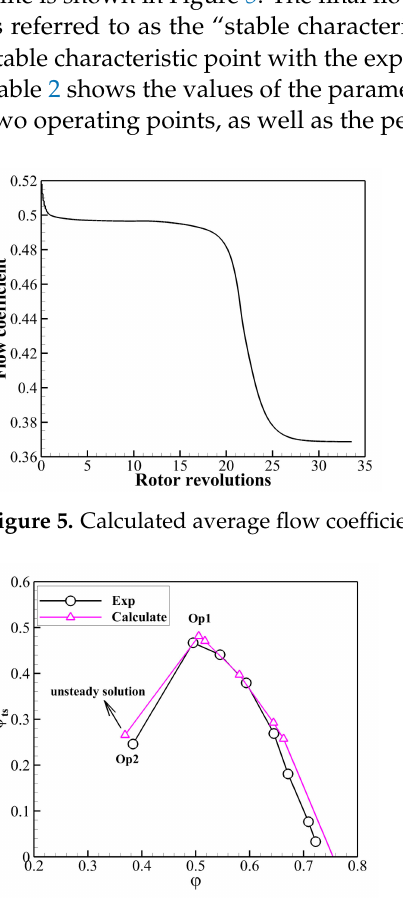
Figure 6. Calculated and experimental stable characteristic point. Table 2. Percentage errors of calculated and experimental